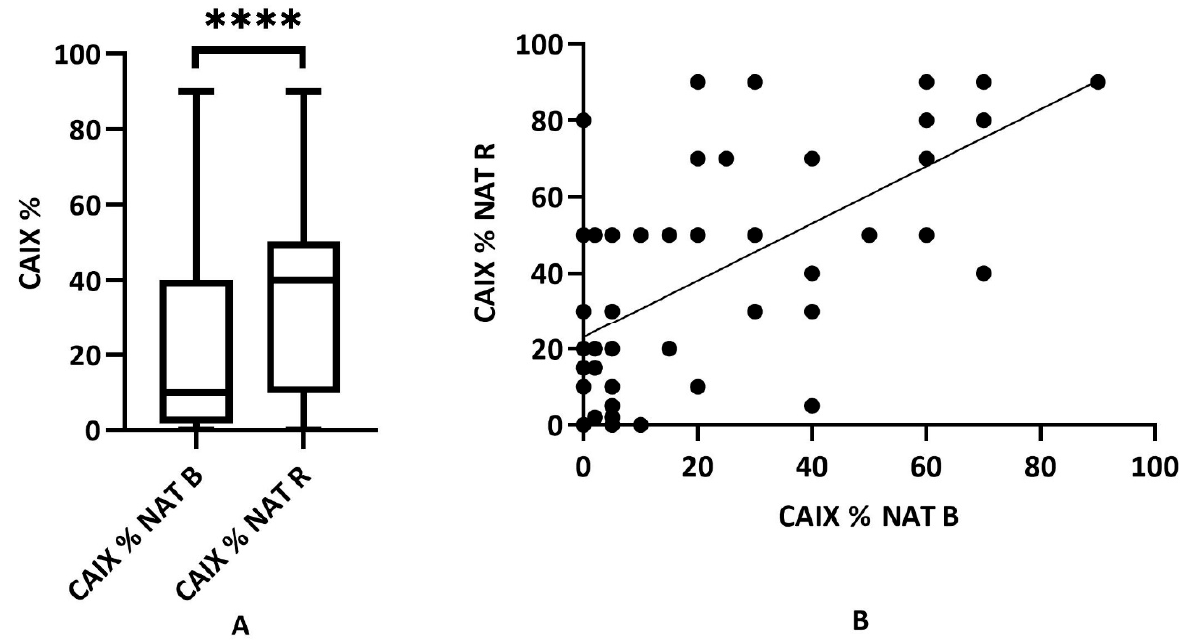
Figure 4. Distribution of CAIX expression in NAT biopsies (NAT B) and NAT surgical resection samples (NAT R) ( n = 55). ( A ) Cumulative result of CAIX tumor labeling (range 0–90% for both groups, mean 21.8 ± 24.9 SD vs. 39.4 ± 29.4 SD, respectively), where the CAIX labeling is significantly different ( p < 0.0001, ****: statistically highly significant); ( B ) correlation of CAIX expression determined between NAT B (pretreatment) and NAT R (post-treatment) samples of the NAT cancer group ( p < 0.0001, rho: 0.5654). Table 1. Statistical distribution of CAIX expression concerning clinicopathological parameters of NAT rectal